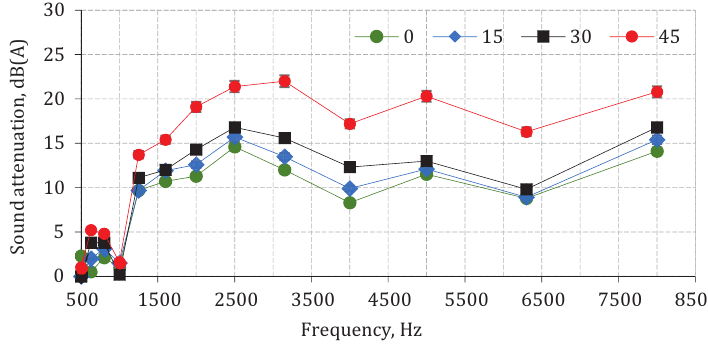
Figure 10. Test results with blades covered with 20 mm thickness of pressed mineral wool on both sides